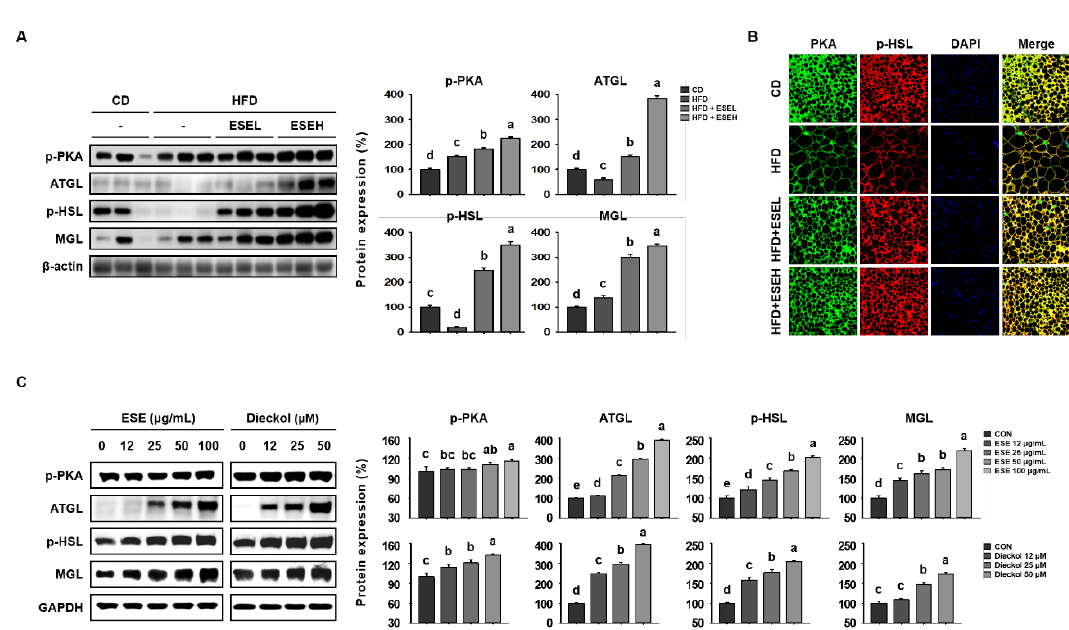
Figure 4. Effects of ESE on the activation of protein kinase A (PKA) and the protein levels of lipolytic enzymes in HFD-fed mice and 3T3-L1 cells. ( A ) Western blots of lipolytic enzymes (phosphorylated protein kinase A (p-PKA), antibodies targeting adipose triglyceride lipase (ATGL), phosphorylated hormone-sensitive lipase (p-HSL), and monoacylglycerol lipase (MGL)) in WAT. ( B ) Immunofluorescence images of WAT (200× magnification). ( C ) Western blots of lipolytic enzymes in 3T3-L1 cells. Data are expressed as means ± SDs ( n = 4). Values with different letters are significantly different: p < 0.05 (a > b > c > d > e).